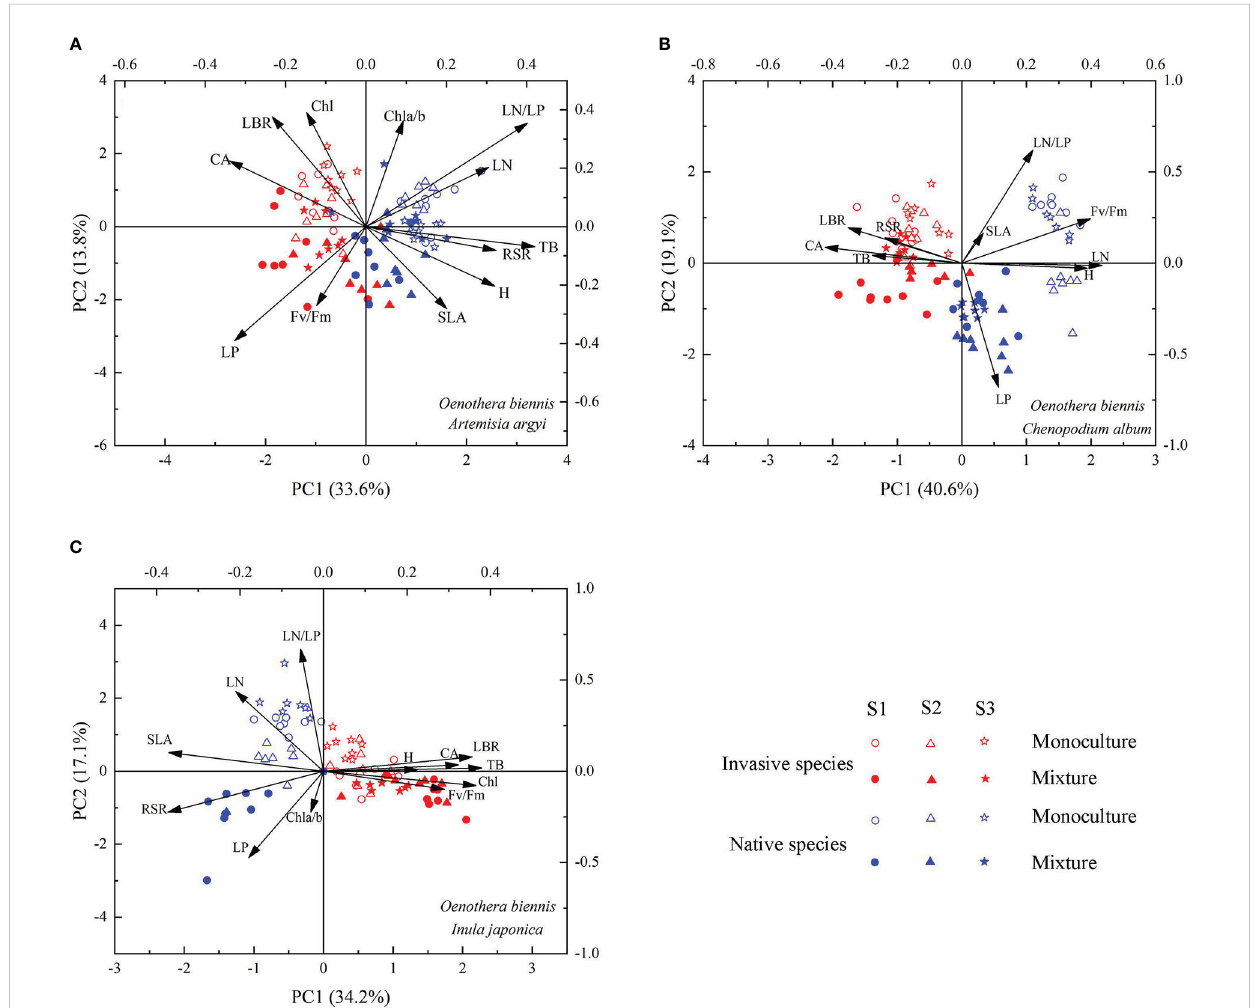
FIGURE 6 Principal component analysis of Oenothera biennis and three native species ( Artemisia argyi , Chenopodium album , and Inula japonica ) across three levels of soil salinity and two cultivation types based on 12 functional traits. Abbreviations have identical meanings as described in Table